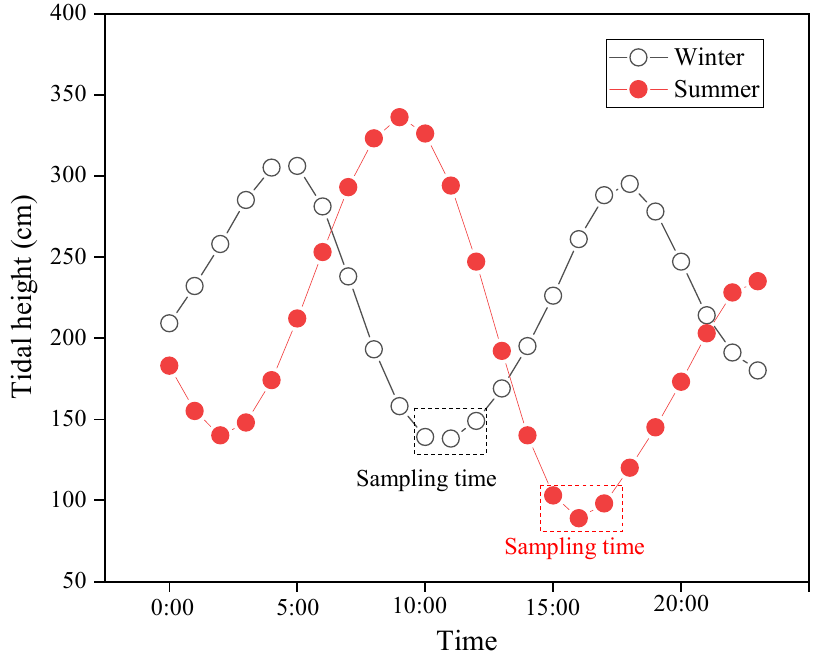
Figure 2. Seasonal variations in height for the tide in Zhanjiang Bay.